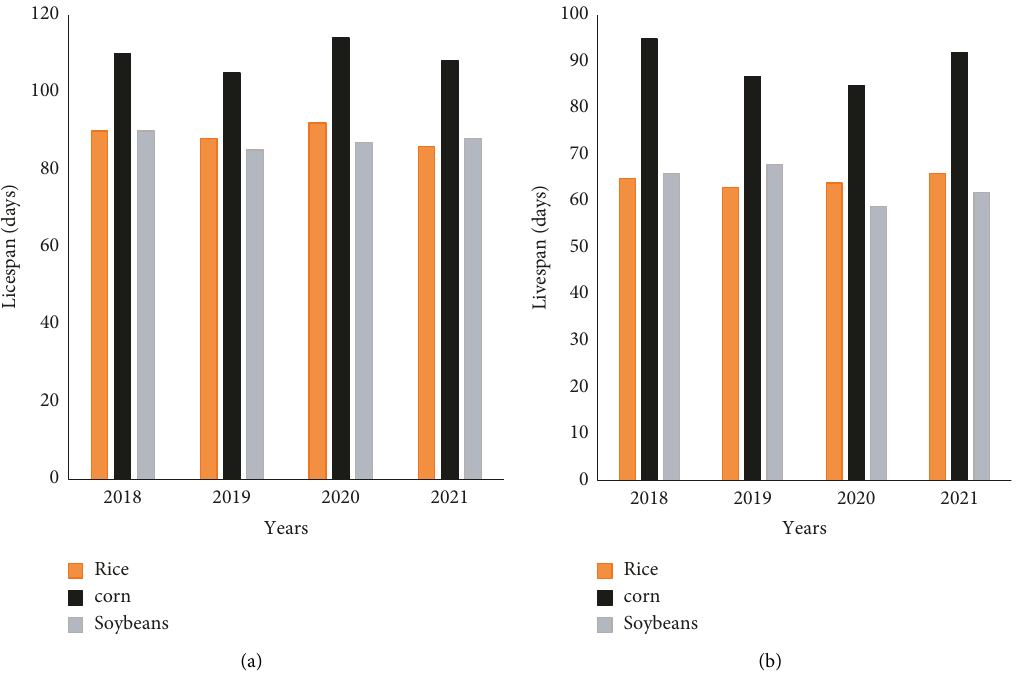
Figure 6: The growth cycle of traditional crops and synthetic crops in different